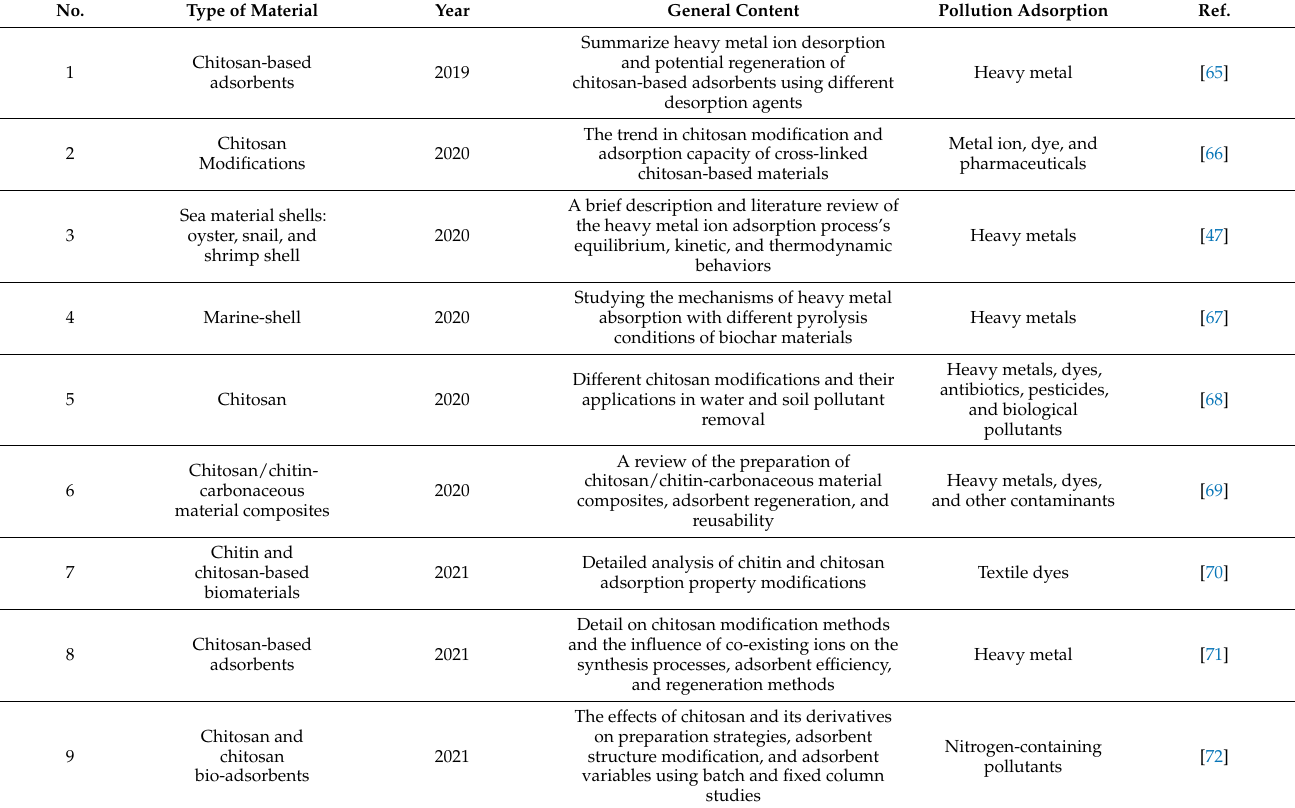
Table 1. Summary of review articles on wastewater treatment related to sea material in recent years.